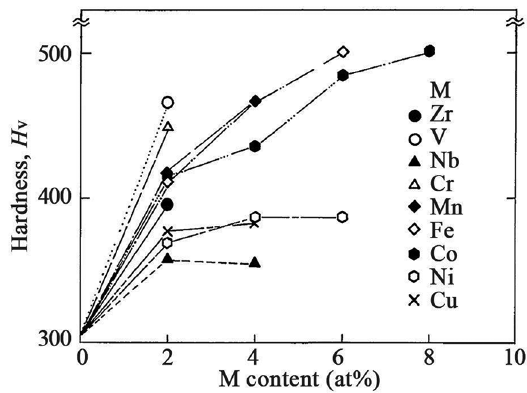
Figure 2. Changes in Vickers hardness ( H (M=Zr, V, Nb, Cr, Mn, Fe, Co, Ni or Cu) amorphous alloys with an increase of the M content 9 .